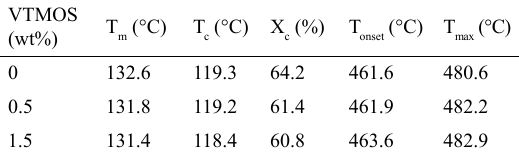
Table 4. Thermal properties of HMWPE and VTMOS crosslinked HMWPE samples.